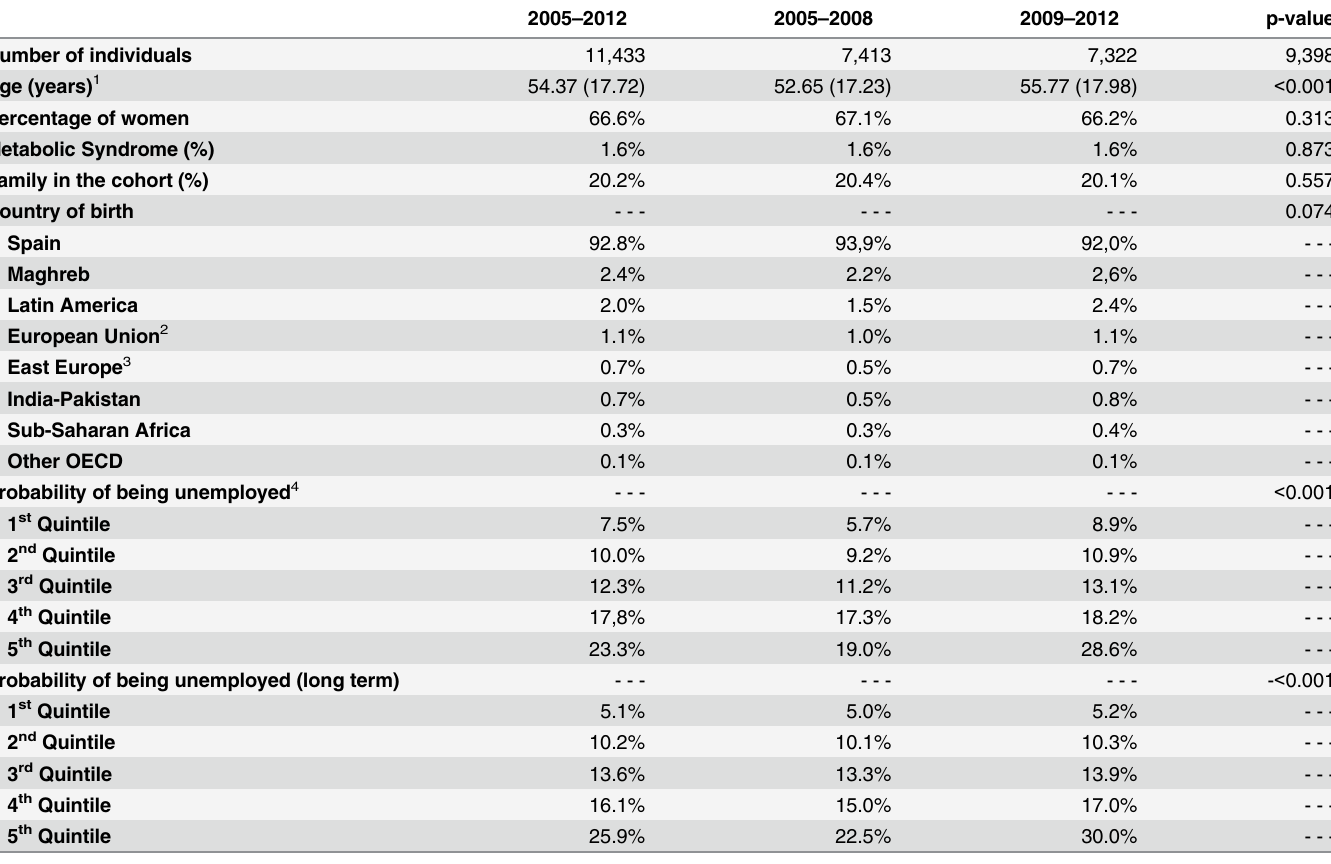
Table 1. Characteristics of the